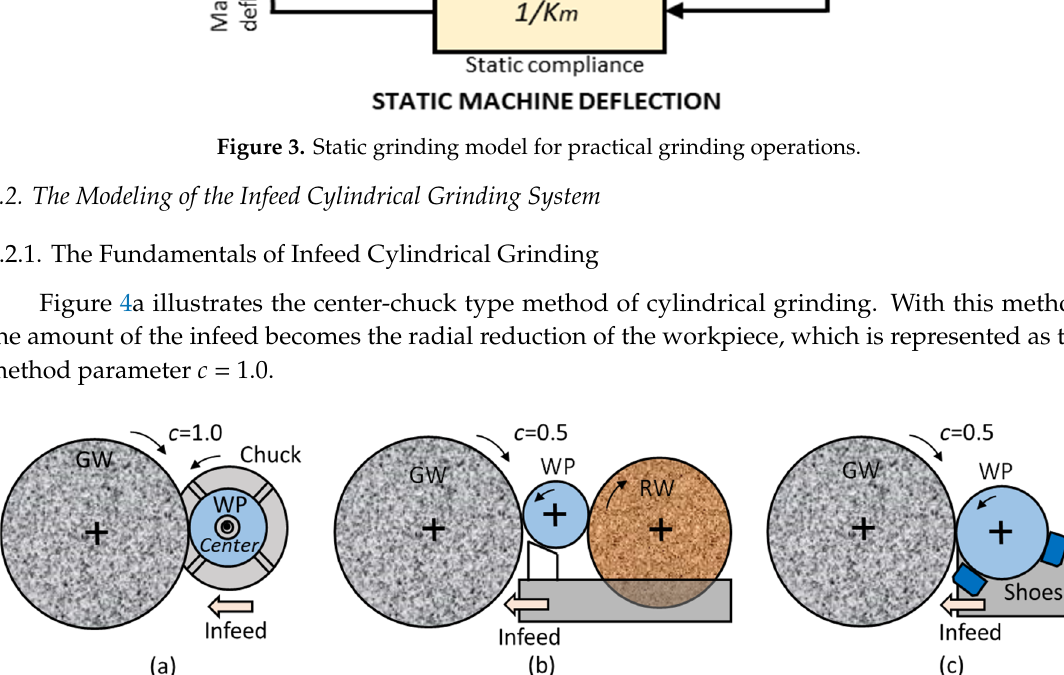
Figure 3. Static grinding model for practical grinding operations.